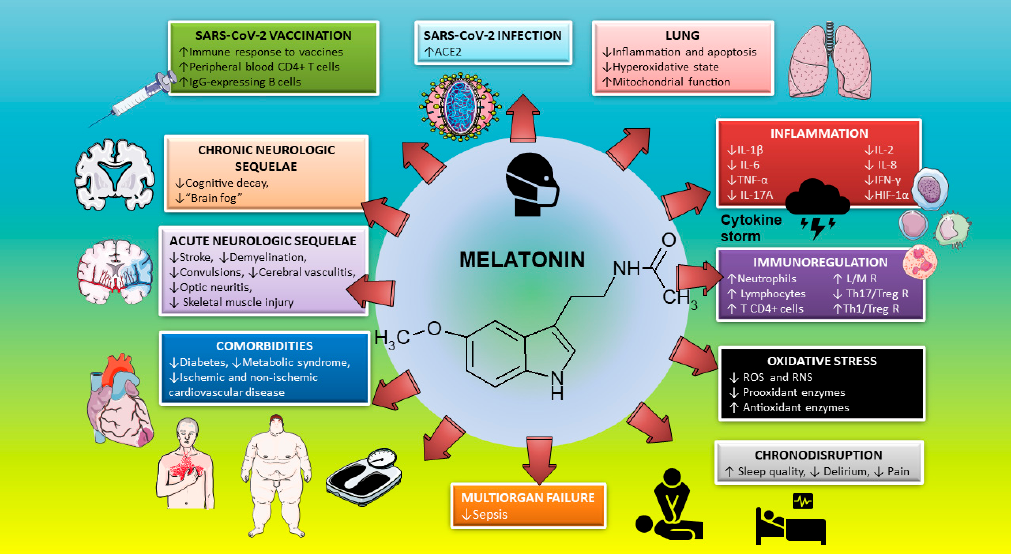
Figure 2. Melatonin as a multifactorial therapeutic agent in SARS-CoV-2 infection. For explanation, see text. ROS: radical oxygen species; RNS: radical nitrogen species. L/M R: lymphocyte/monocyte ratio.